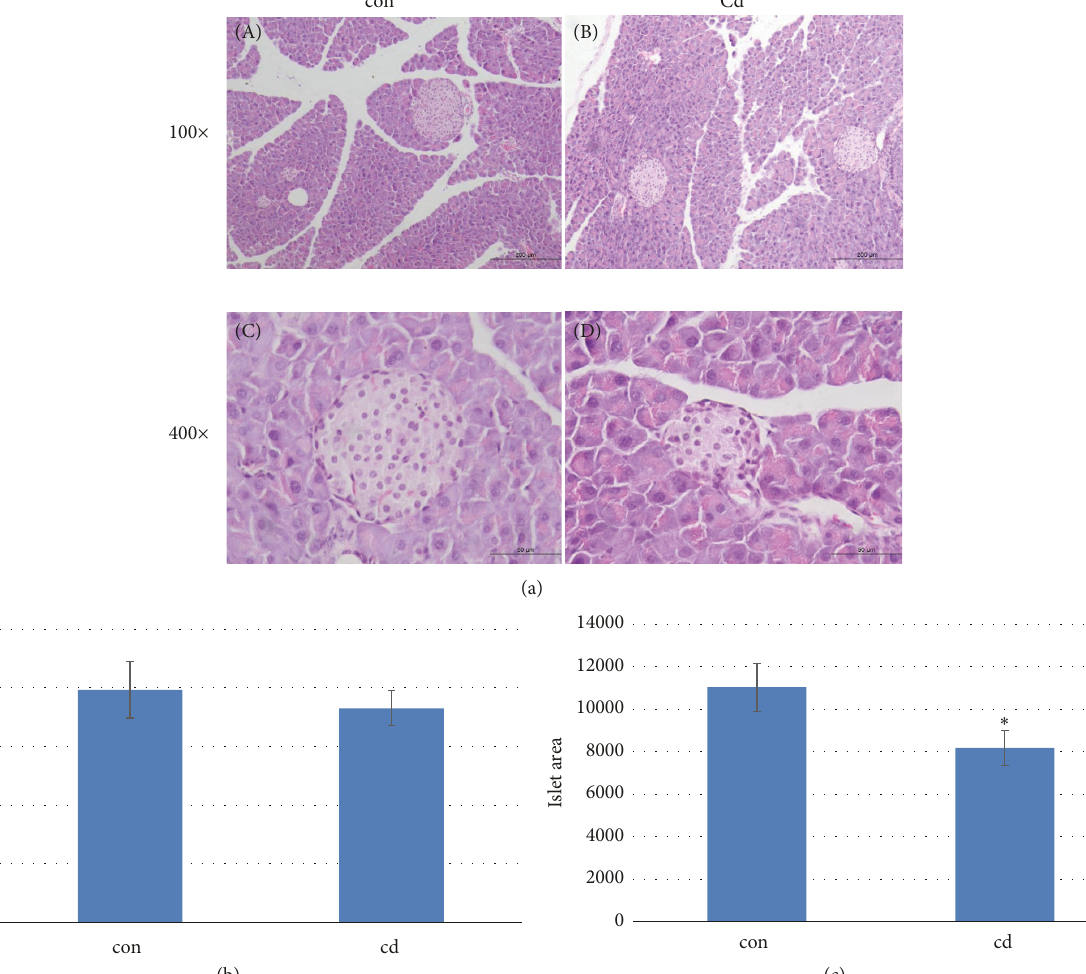
Figure 5: Histopathological evaluation of chronic Cd exposure (cadmium chloride; 1 mg.kg −1 , intraperitoneal injection, twice weekly) on pancreas tissue in male C57BL/6 mice (n=5/group) (a): (A), (B): 100 × ; (C), (D): 400 × . Tissue samples were fixed in 4% neutral buffered formalin, embedded in paraffin, sectioned, and stained with H&E. (A), (C): pancreas tissue of control mice; (B), (D): pancreas tissue of chronic Cd-exposed mice showing islet atrophy. (b): islet numbers in control and Cd-exposed mice. (c): the areas of pancreatic islets in control and Cd-exposed